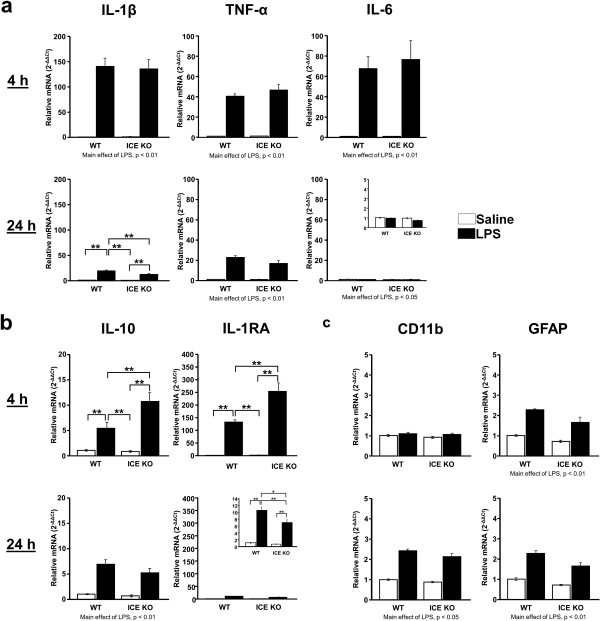
Both ICE KO and WT mice given systemic LPS exhibited increased expression of inflammatory markers in brain. In both WT and ICE KO mice, LPS injected IP induced expression of (a) IL-1β, TNF-α, and IL-6 at 4 h. All but IL-6 remained elevated at 24 h. (b) ICE KO mice had greater expression of IL-10 and IL-1RA at 4 h. However, at 24 h, the LPS-induced increase in IL-10 expression was similar in both strains of mice while that of IL-1RA was reduced in ICE KO mice. (c) CD11b was not elevated by LPS until 24 h post-treatment while GFAP expression was increased at both 4 h and 24 h similarly in WT and ICE KO mice. Data are average mRNA expression levels relative to GAPDH ± SEM, **P <0.01, *P <0.05 comparing bracketed groups; main effects of LPS where indicated; n = 5 to 6 mice per group. Insets: Data presented with zoomed in scale to ease interpretation. Mean Ct values for saline treated WT groups were: IL-1β, 29.5 ± 0.1; TNF-α, 29.6 ± 0.1; IL-6, 29.2 ± 0.1; IL-10, 34.9 ±0.1; IL-1RA, 30.4 ± 0.3; CD11b, 21.6 ± 0.1; GFAP, 18.0 ± 0.1.